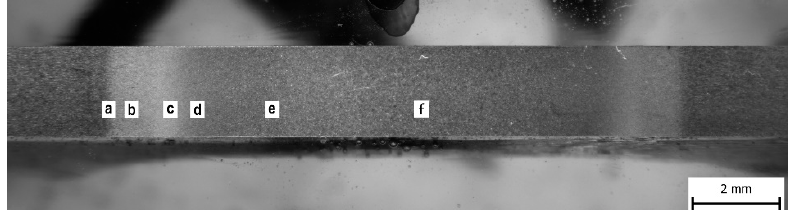
Figure 16. Macrostructure of the 7s sample with marked spots of microstructure evaluation: ( a ) Base material (BM)—inter-critical heat-affected zone (ICHAZ) transition area; ( b ) ICHAZ area; ( c ) ICHAZ—fine-grained area of the heat-affected zone (FGHAZ) transition area; ( d ) FGHAZ area; ( e ) FGHAZ—coarse grain heat-affected zone (CGHAZ) transition area; ( f ) CGHAZ area.